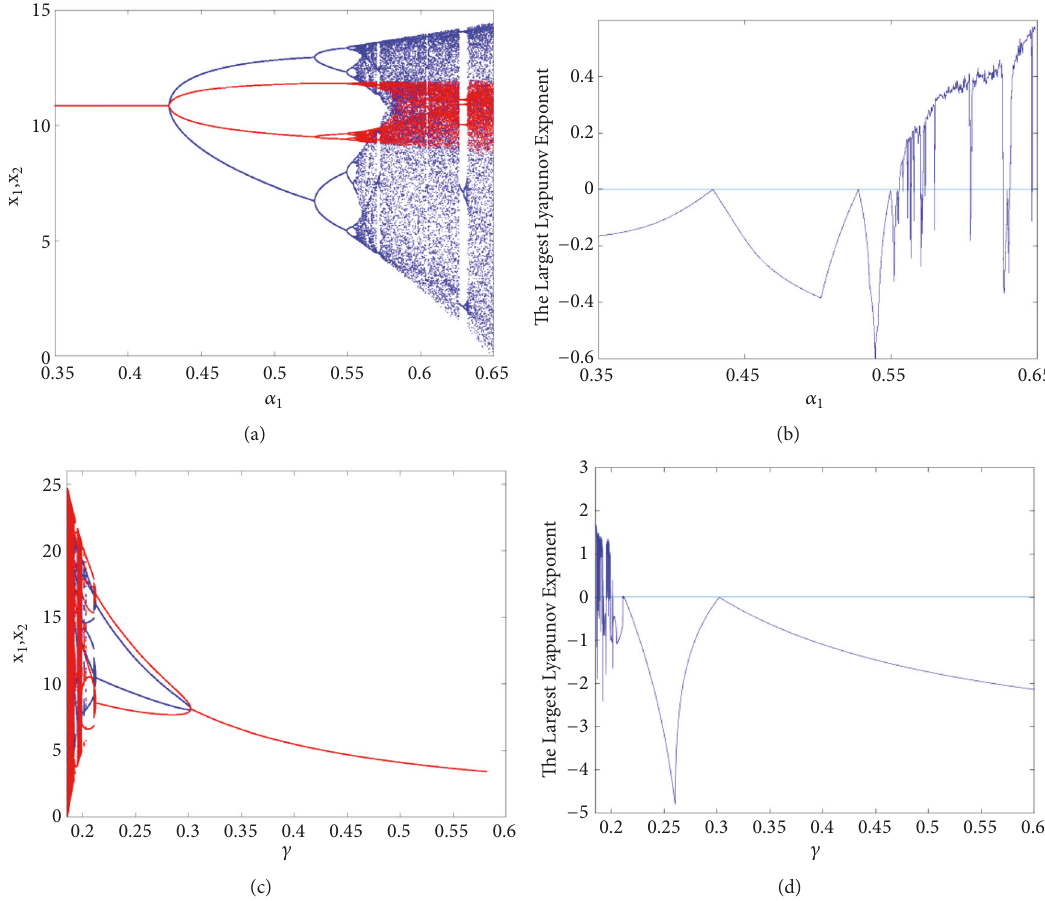
Figure 4: (a) The one-parameter bifurcation diagram with 𝑎 = 7.12 , 𝑏 = 0.024 , 𝑐 = 0.98 , 𝛽 = 0.38 , 𝛾 = 0.44 , and 𝛼 2 = 0.4 , where the bifurcation parameter is chosen as 𝛼 1 . (b) The corresponding largest Lyapunov exponent of (a). (c) The one-parameter bifurcation diagram with 𝑎 = 2.679 , 𝑏 = 0.061 , 𝑐 = 0.105 , 𝛼 1 = 0.666 , and 𝛼 2 = 0.9 , where the bifurcation parameter is chosen as 𝛾 . (d) The corresponding largest Lyapunov exponent of